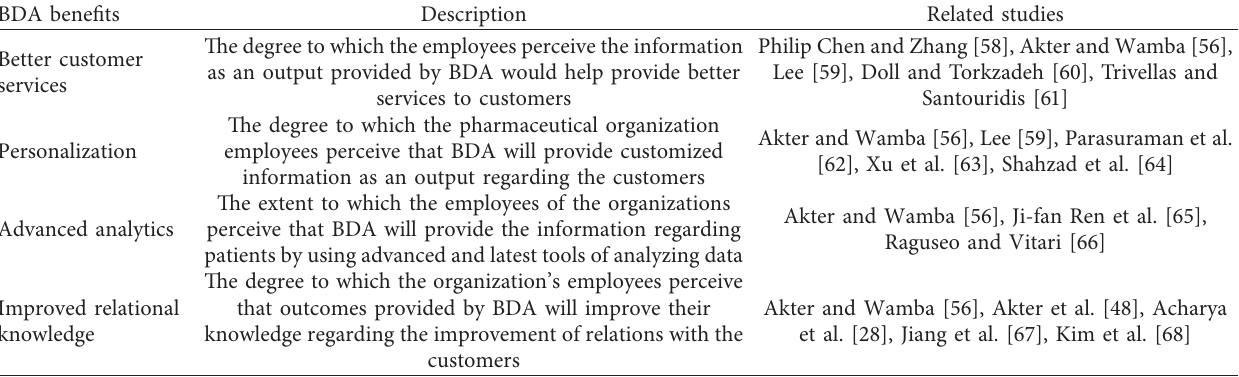
Table 1: Enabling big data analytics